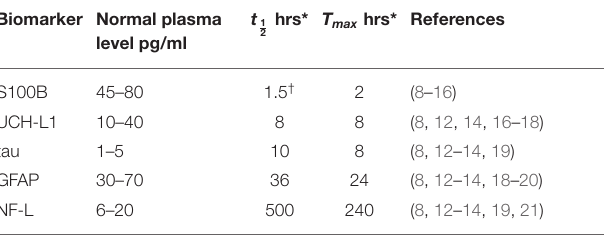
TABLE 1 | Estimated kinetic parameters from literature review. Biomarker Normal plasma level